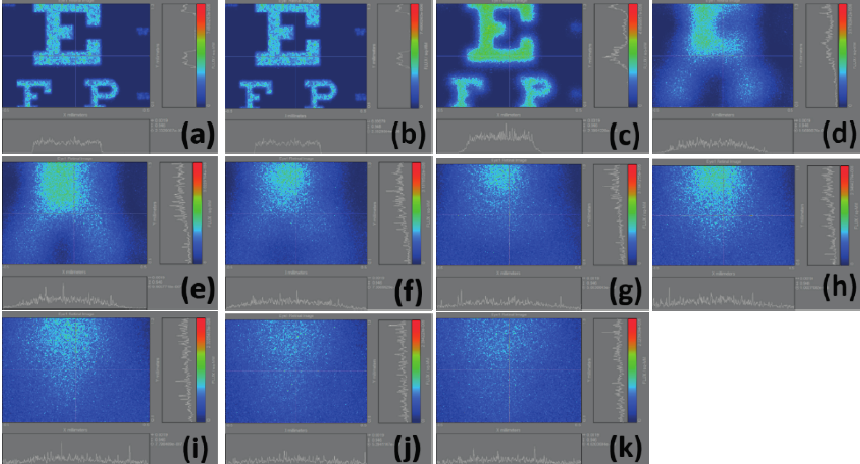
Figure 6. Calculation results of retinal images by selecting the whole Snellen chart in Figure 3(c); ( a ) plano; ( b ) 1.00 D; ( c ) 2.00 D; ( d ) 3.00 D; ( e ) 4.00 D; ( f ) 5.00 D; ( g ) 6.00 D; ( h ) 7.00 D; ( i ) 8.00 D; ( j ) 9.00 D; ( k ) 10.00 D.